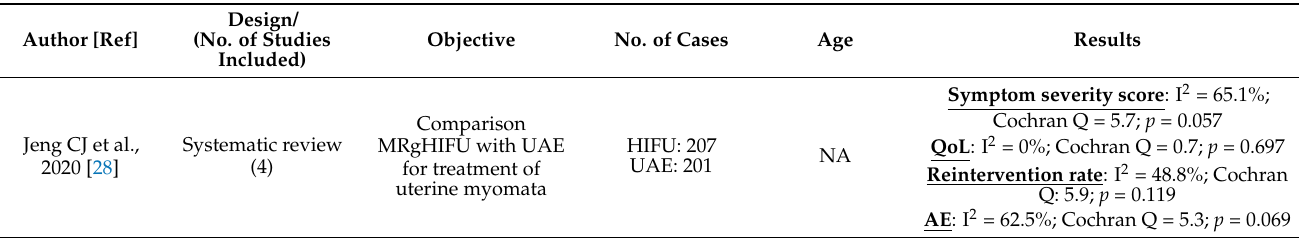
Table 2. Outcomes after HIFU and other uterine sparing therapies reported by meta-analysis and systematic